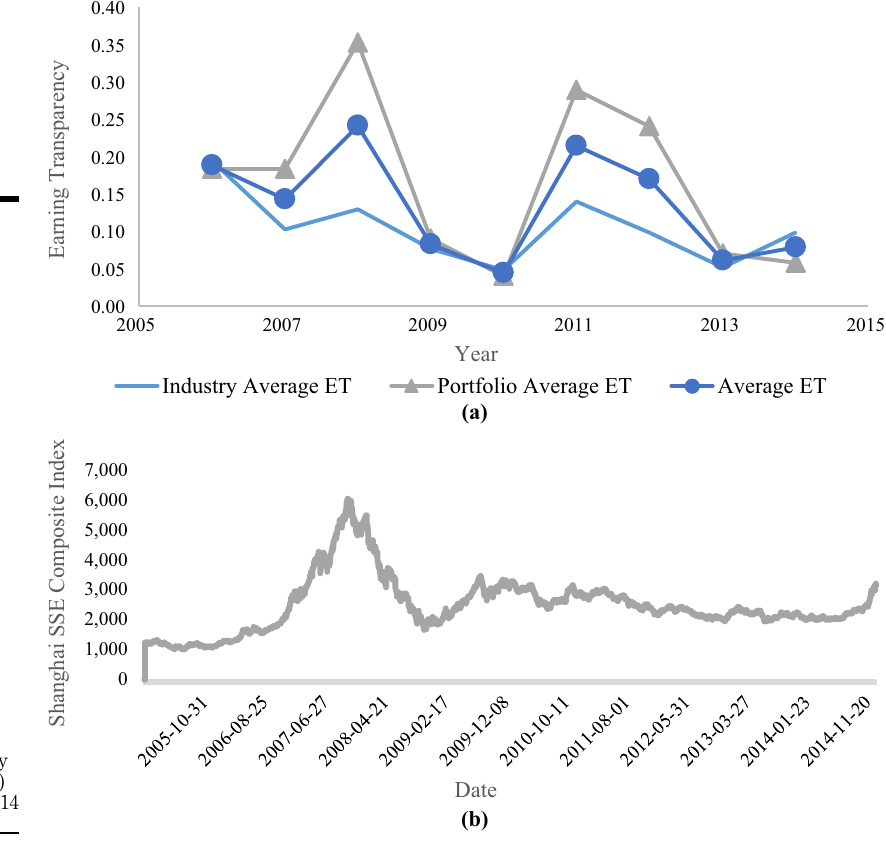
Figure 2. (a) Overall earnings transparency level by year (b) SSE